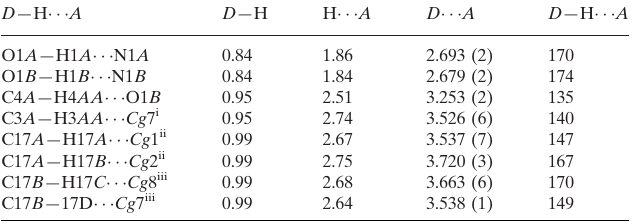
Hydrogen-bond geometry (A˚ , (cid:2) ). D —H (cid:3)(cid:3)(cid:3)